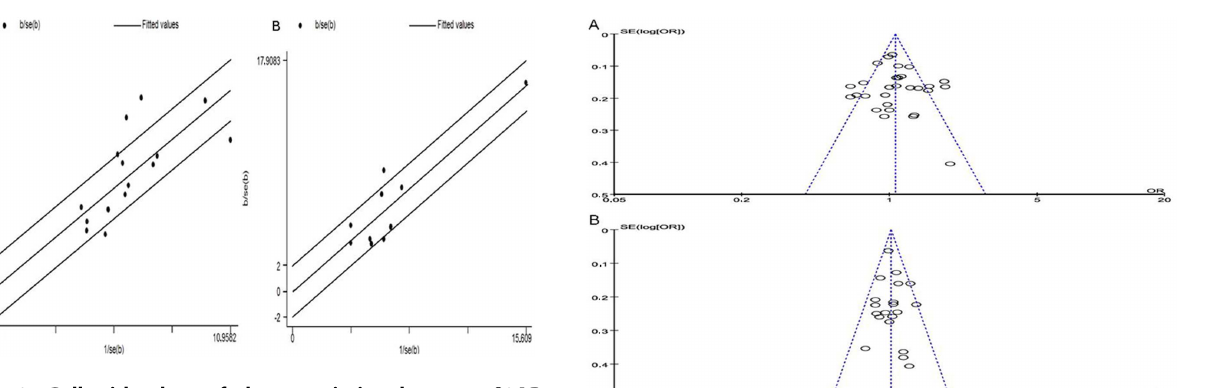
Table S1 Distribution of Arg/Gly 16 genotypes among patients with asthma and controls included in the meta-analysis. Table S2 Distribution of Gln/Gln27genotypes among patients with asthma and controls included in the meta-analysis.